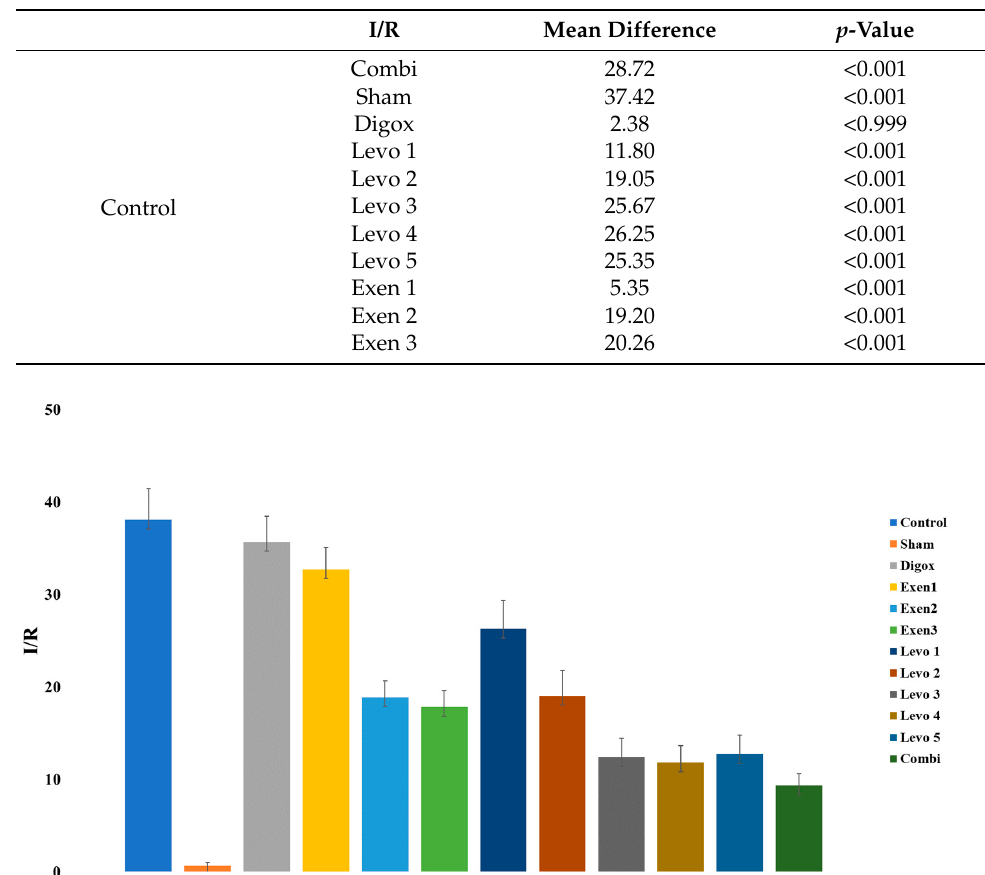
Figure 17. Changes in I/R across groups.